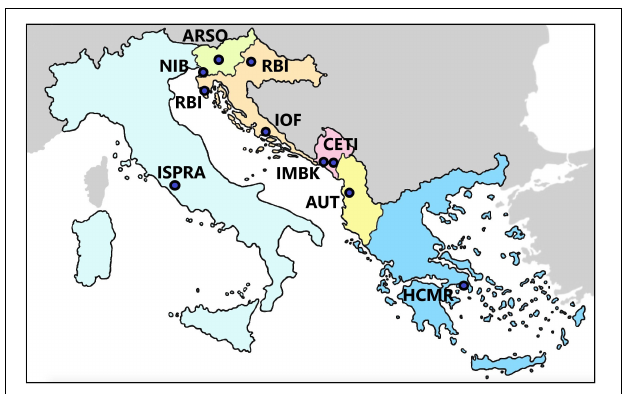
FIGURE 1 | Laboratories from the ADRION countries sharing information used in this